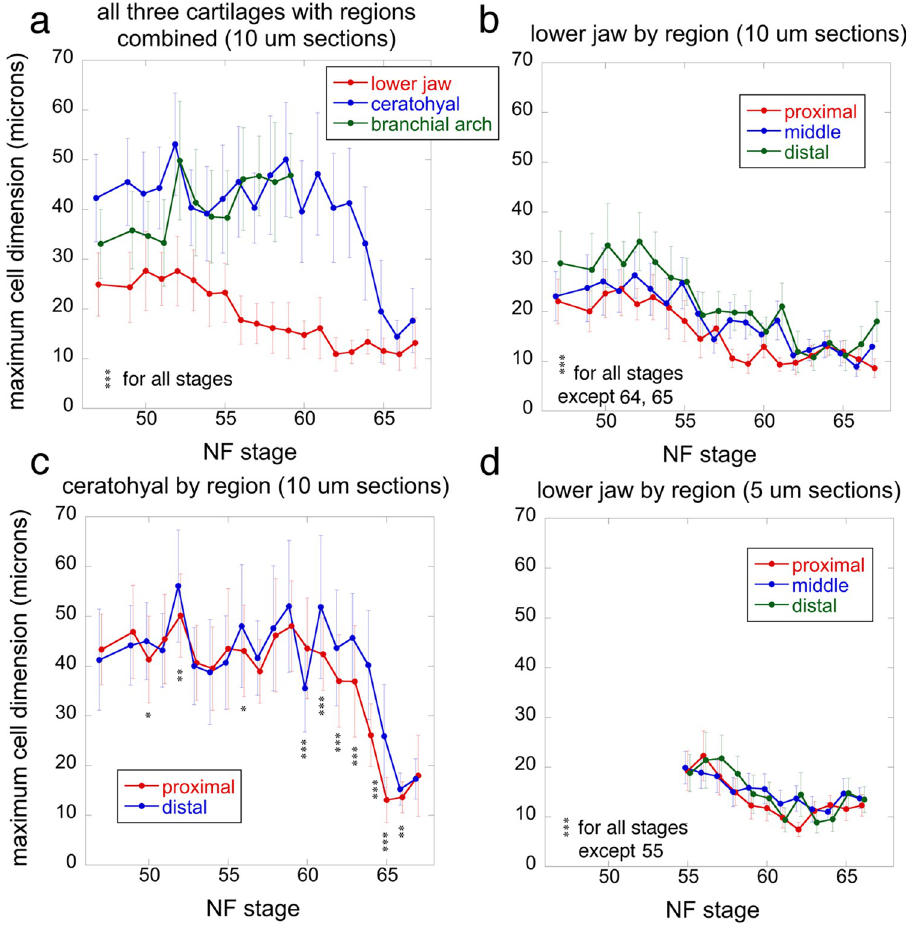
Fig 7. Maximum cell dimensions for lower jaw, ceratohyal and branchial arch cartilages at NF 47–67. Each stage was scored from 40 X photos of the left and right cartilages of a single specimen using the 30 largest chondrocytes in each photo; error bars show standard deviations as standard errors are generally too small to be visible; asterisks indicate a significant difference for a stage among cartilages in a and among regions within a cartilage in b-d; one asterisk means p < 0.05, two means p < 0.01, and three means p < 0.001 using ANOVA in